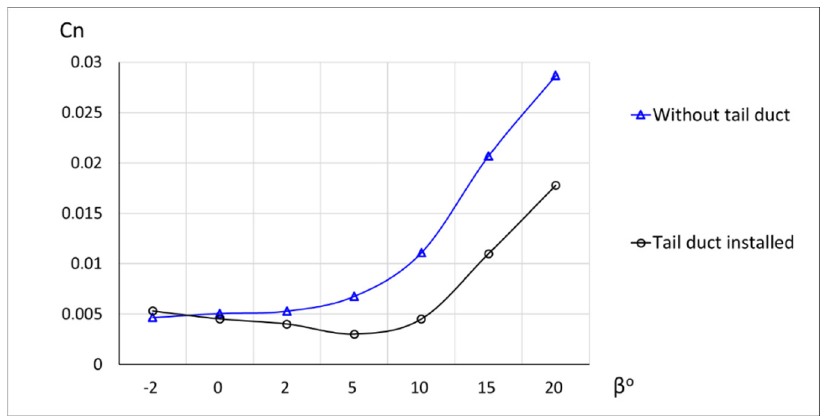
Figure 22. Yaw moment coefficient of the model equipped with a tail duct against the model without a duct.